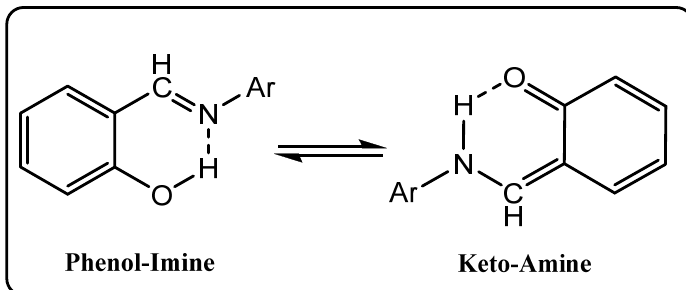
Figure 2. Intramolecular hydrogen bonding in the HB